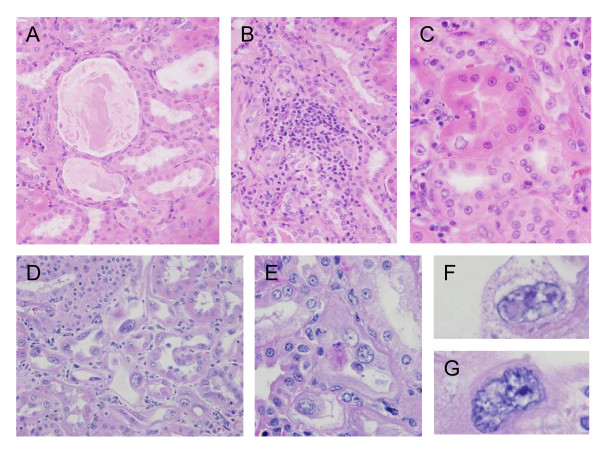
Morphologic features of ART nephropathy. Ectasia of renal tubules containing eosinophilic proteinaceous material (tubular proteinosis) (A) and focal lymphocytic infiltrate (B). Mild cytomegaly and anisonucleosis of proximal convoluted tubule (PCT) (C). Marked nuclear dysplasia with mild cytomegaly and tubular ectasia (D). Focal necrosis of PCT epithelial cell (E). Nuclear dysplasia with cytoplasmic inclusion and nuclear vesiculation (F) and early lobulation (G).